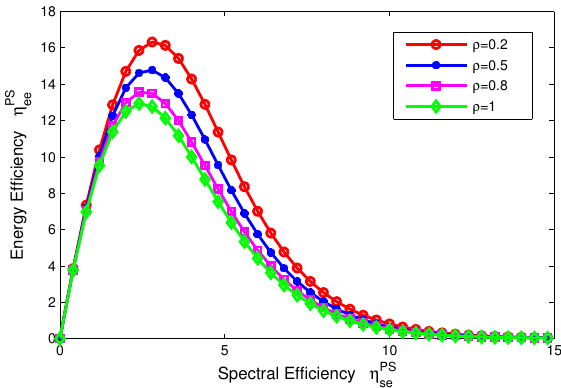
Figure 4. Tradeoff of EE-SE with different power splitting ratios for PS